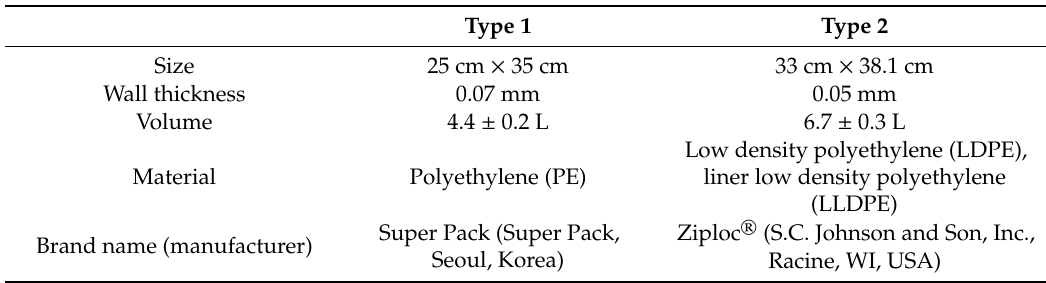
Table 1. Collection bag